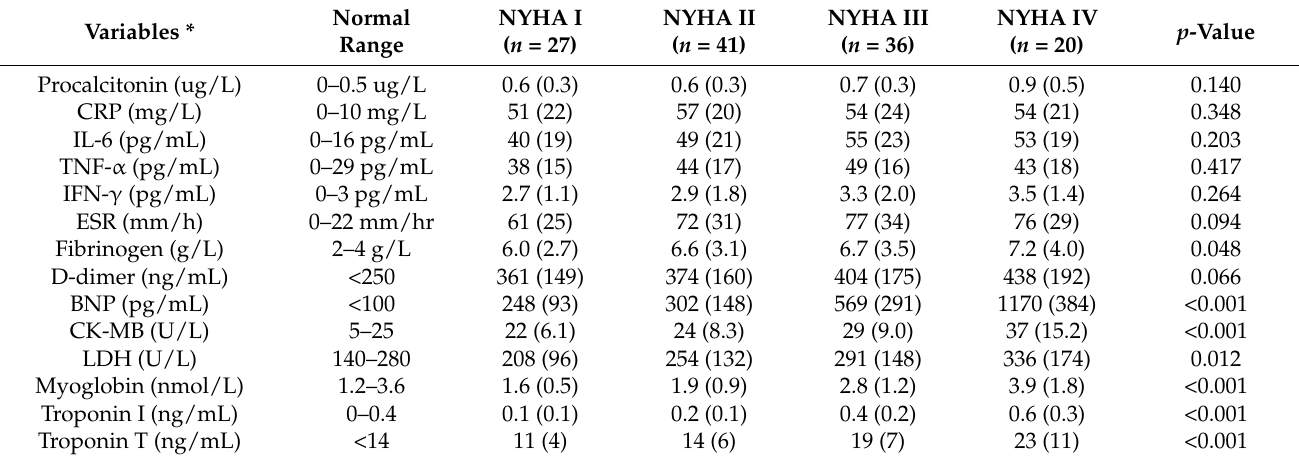
Table 3. Comparison of inflammatory markers by NYHA classification of hospitalized heart failure patients with COVID ‐ 19.